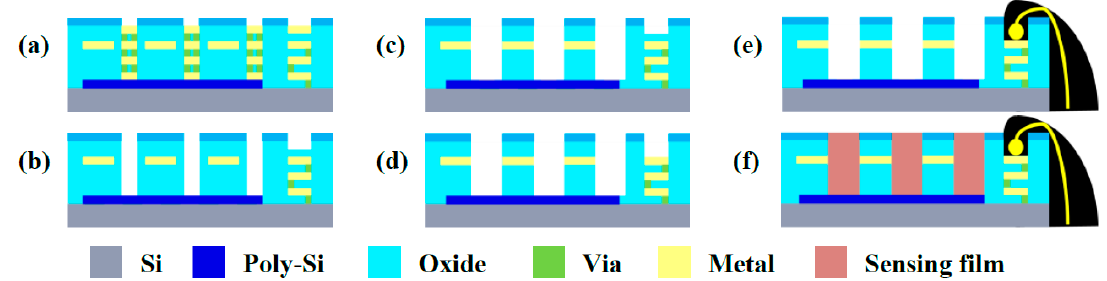
Figure 2. ( a ) TSMC 0.35 μ m 2P4M process, and ( b – f ) post-CMOS fabrication processes to implement the proposed gas